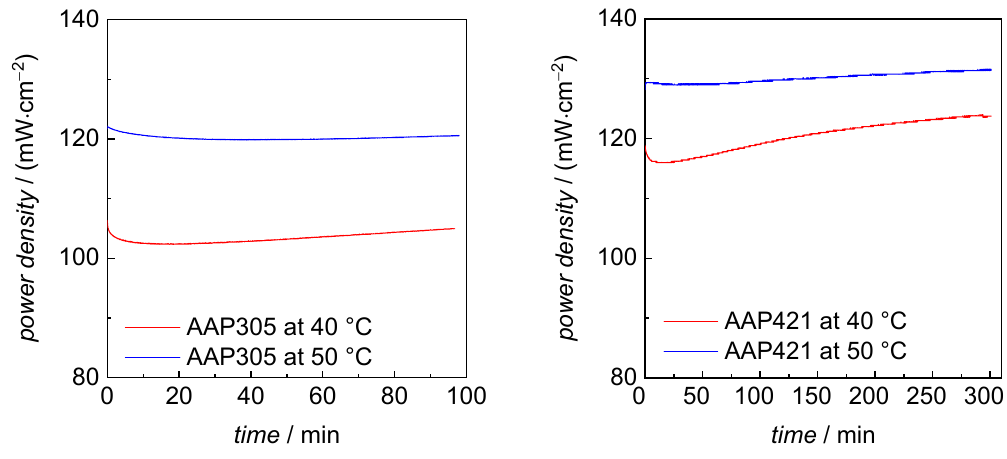
Figure 6. Power densities for membranes AAP305 and AAP421 determined in fuel cell tests at the indicated temperatures.